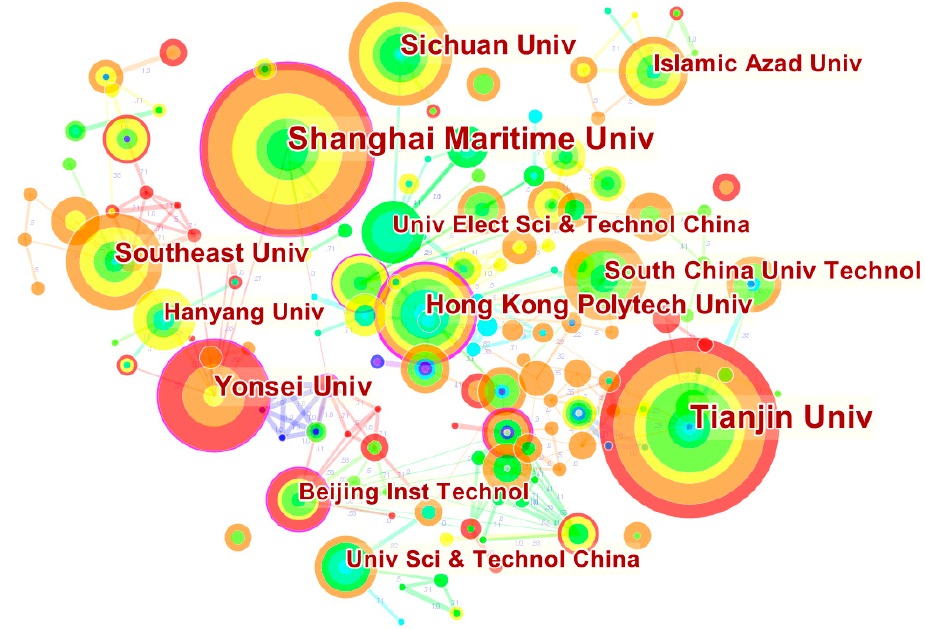
Figure 3. Visualization network map of the institution co-authorship analysis.